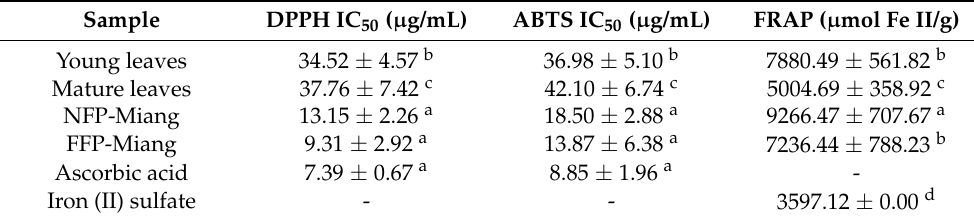
Table 2. Antioxidant activities of Miang samples determined by DPPH, ABTS, and FRAP assays using L-ascorbic acid as a positive control in comparison to FRAP assay using iron (II) sulfate as a